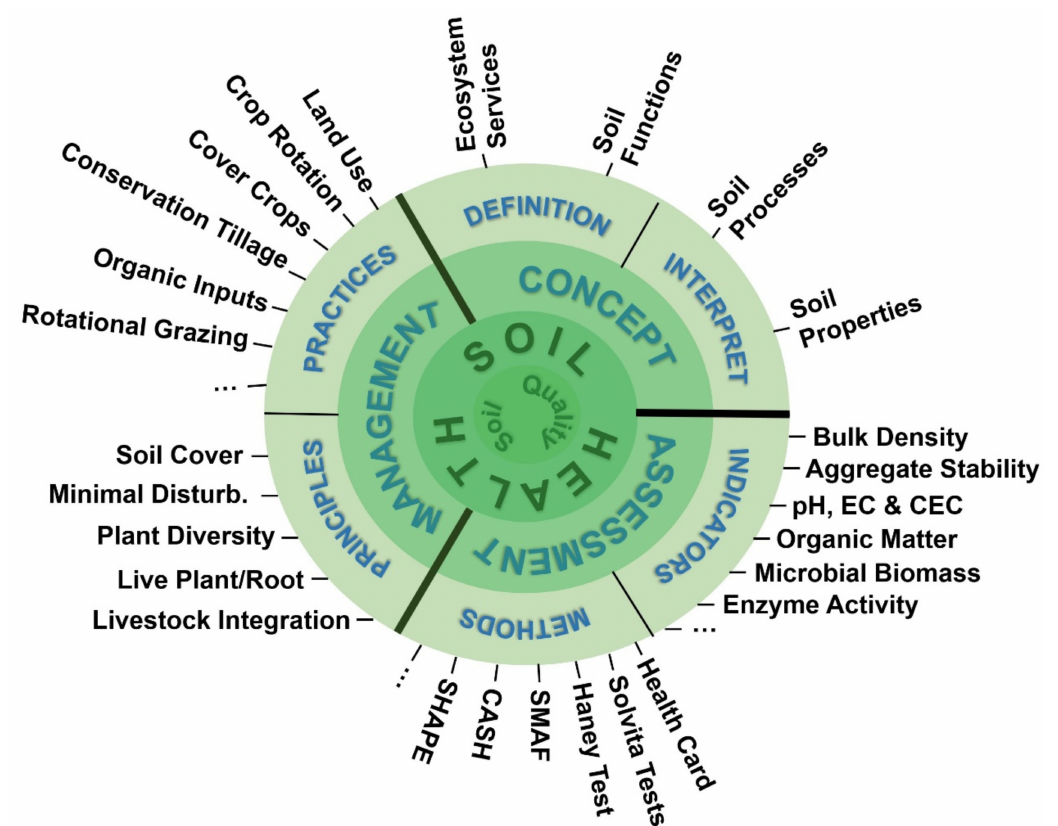
Figure 2. Development of the science of soil health with concept, assessment, and management as the three focal areas. CEC: cation exchange capacity; EC: electrical conductivity; CASH: comprehensive assessment of soil health; SHAPE: soil health assessment protocol and evaluation; SMAF: soil management assessment